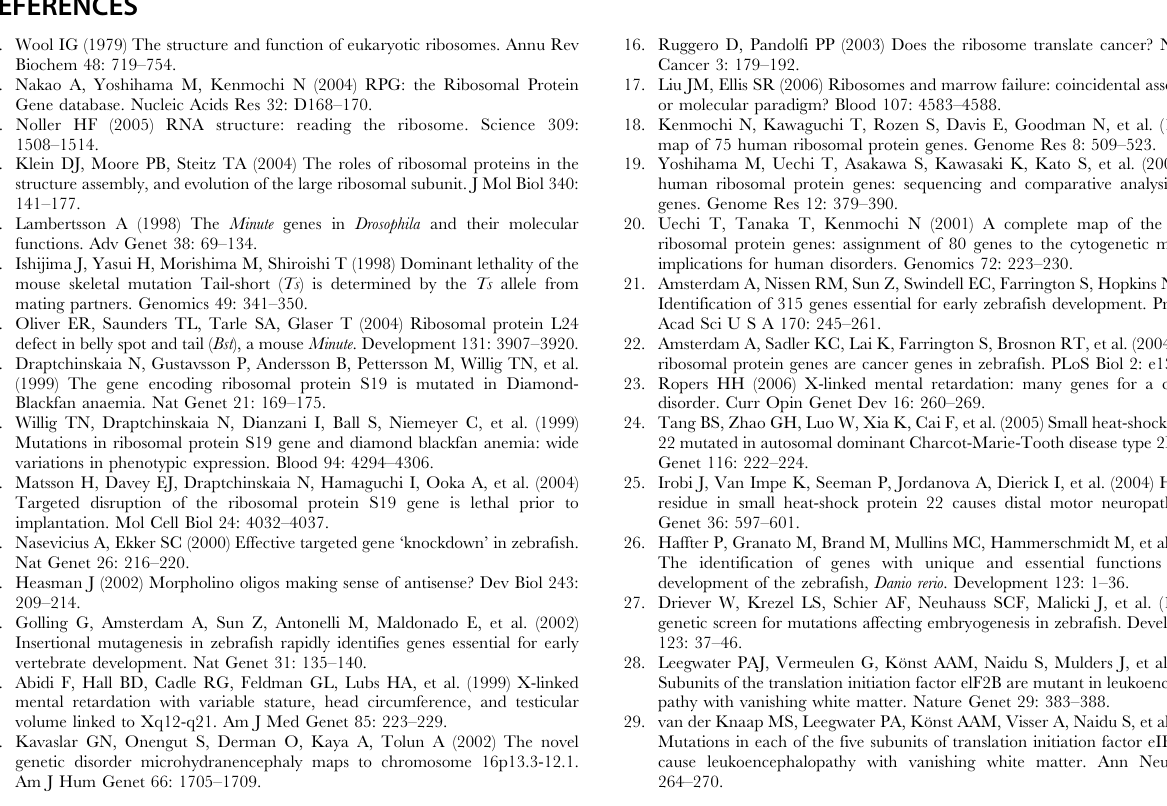
Table S1 The Sequences of the Morpholino Antisense Oligos Used in This Study